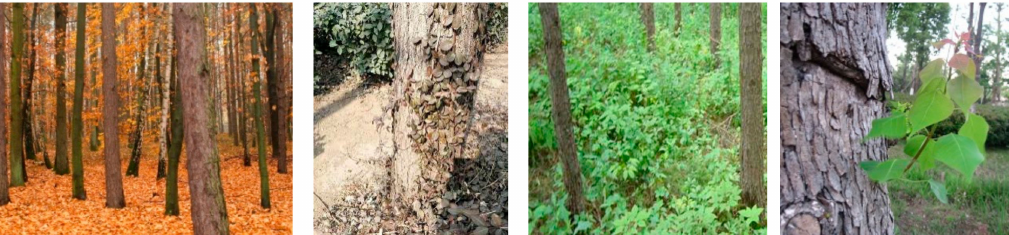
Figure 11. Ground truth images of standing trees.